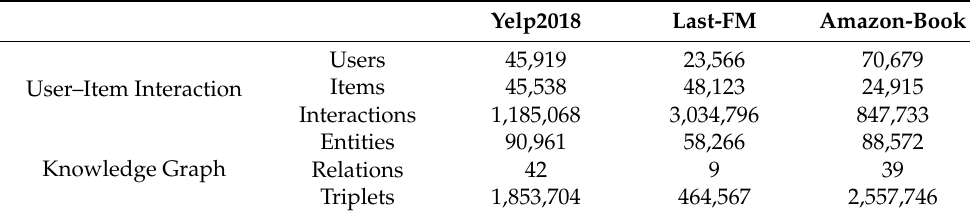
Table 1. Statistics of the data